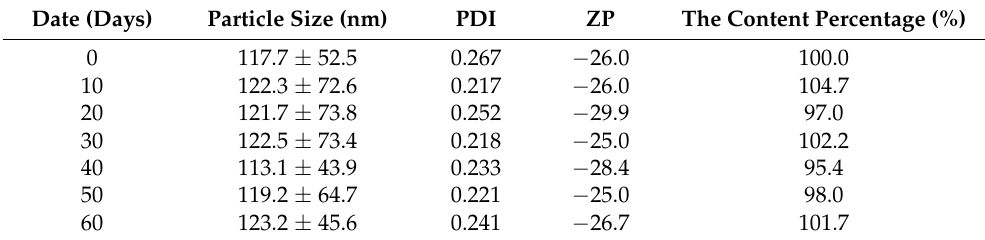
Table 2. The size, PDI, and the content of IMB16-4 of IMB16-4 − LNPs lyophilized powder over 60 days. The drug content was measured three times.